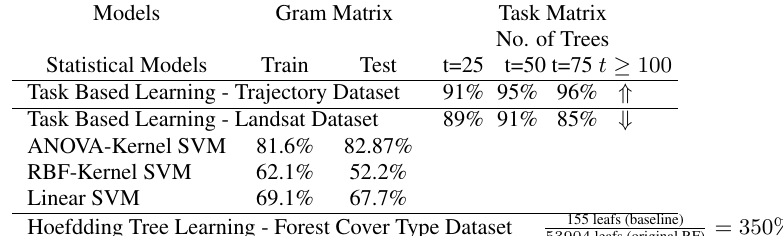
TABLE V Prediction Error: Results for the UCI-Landsat dataset when post-processing to predict or categorize the datasets using unknown test samples. The timings included show training time during learning the